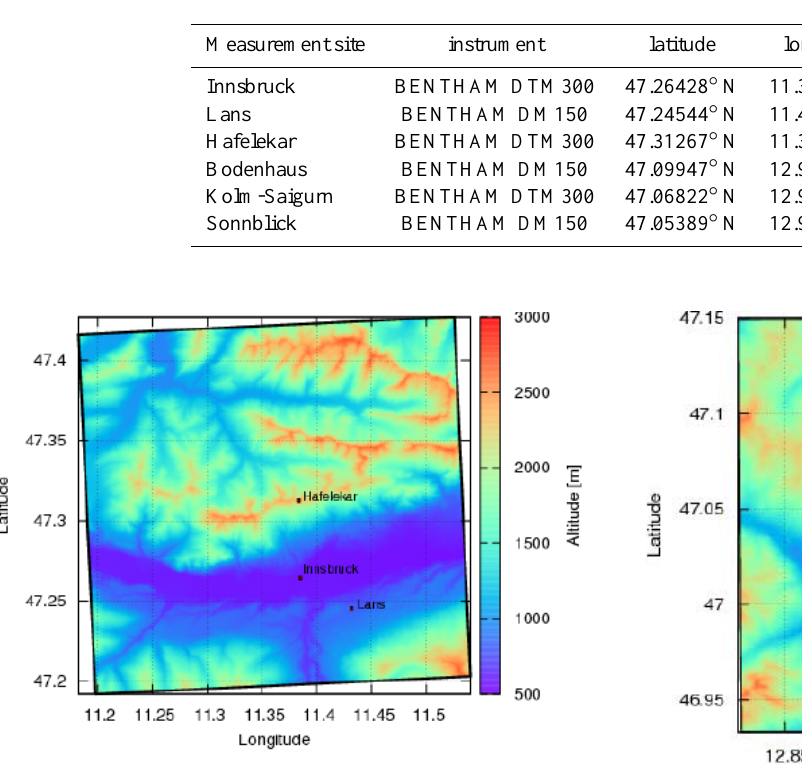
Table 2. Information on ground-based stations used in this study.